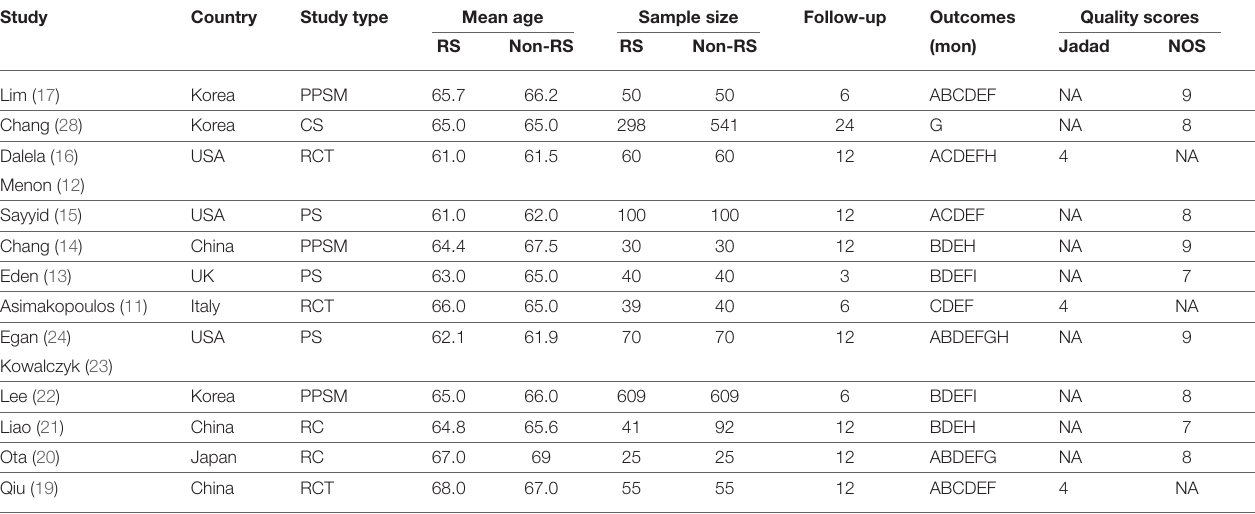
TABLE 1 | Literature basic information and literature quality evaluation results.